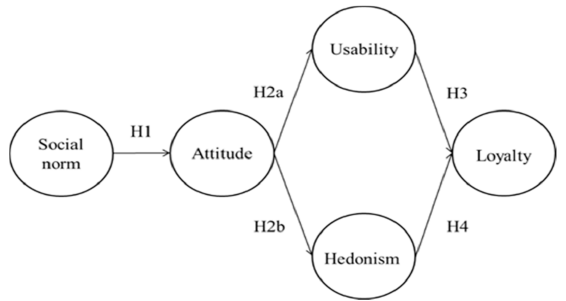
Figure 1. A suggestion for a path model explaining effects on loyalty in OTAs Proposed model. Source: Own elaboration.